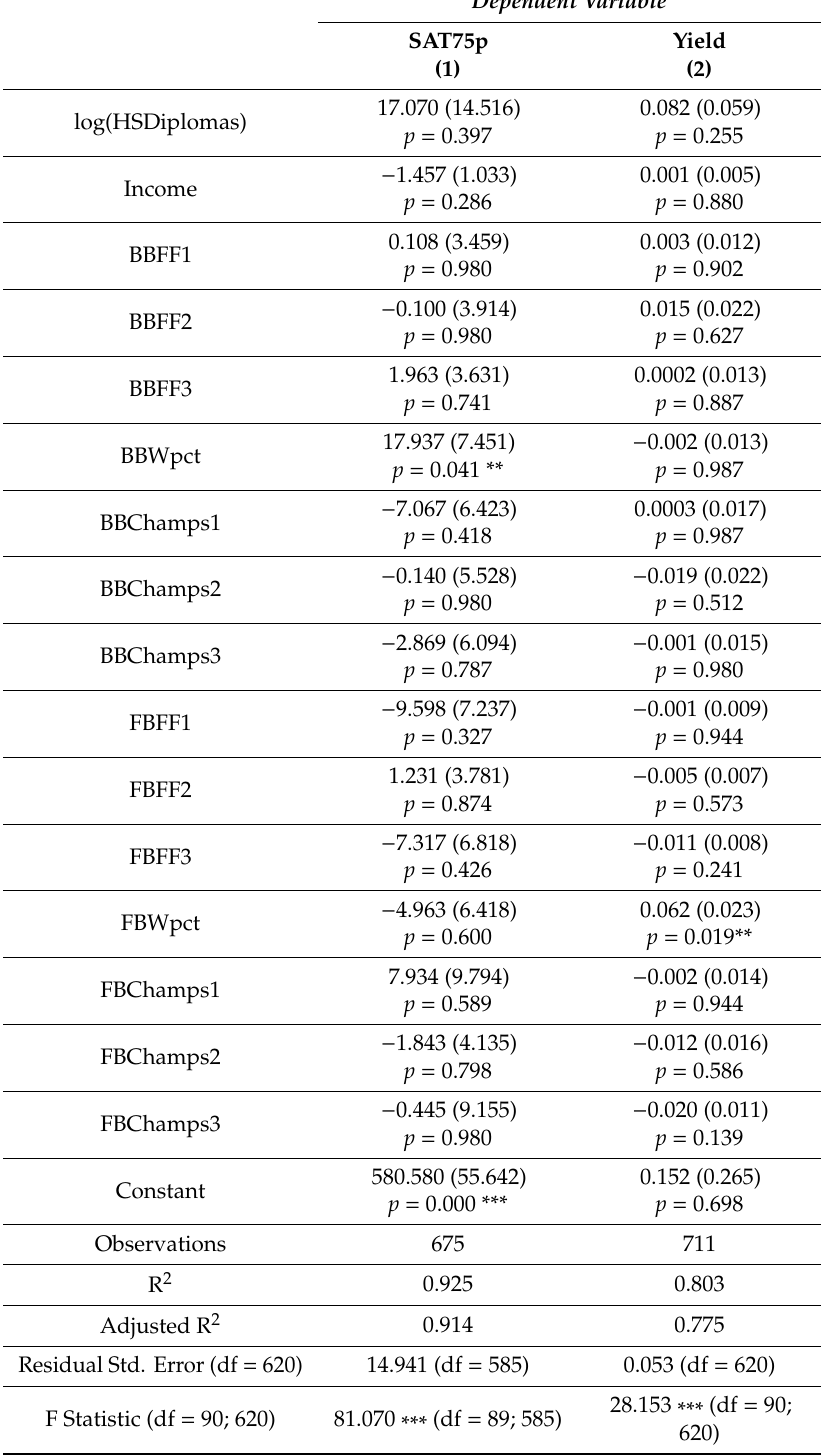
Table 4. Models for